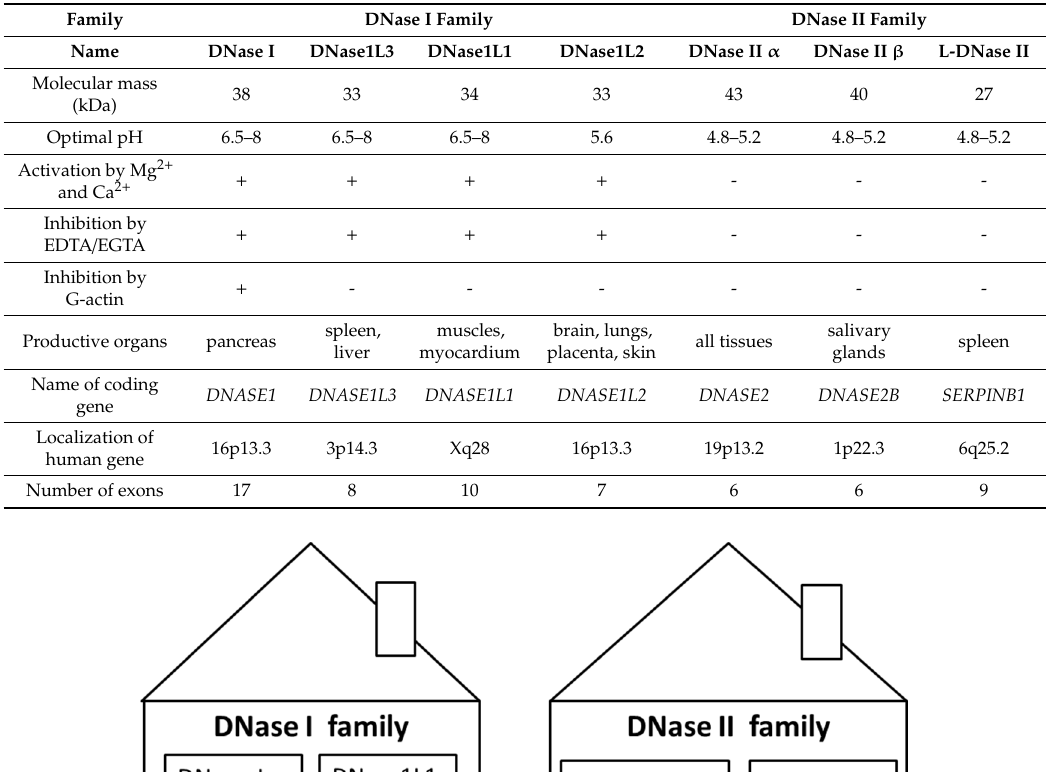
Table 1. Characterization of different types of deoxyribonucleases (DNases).